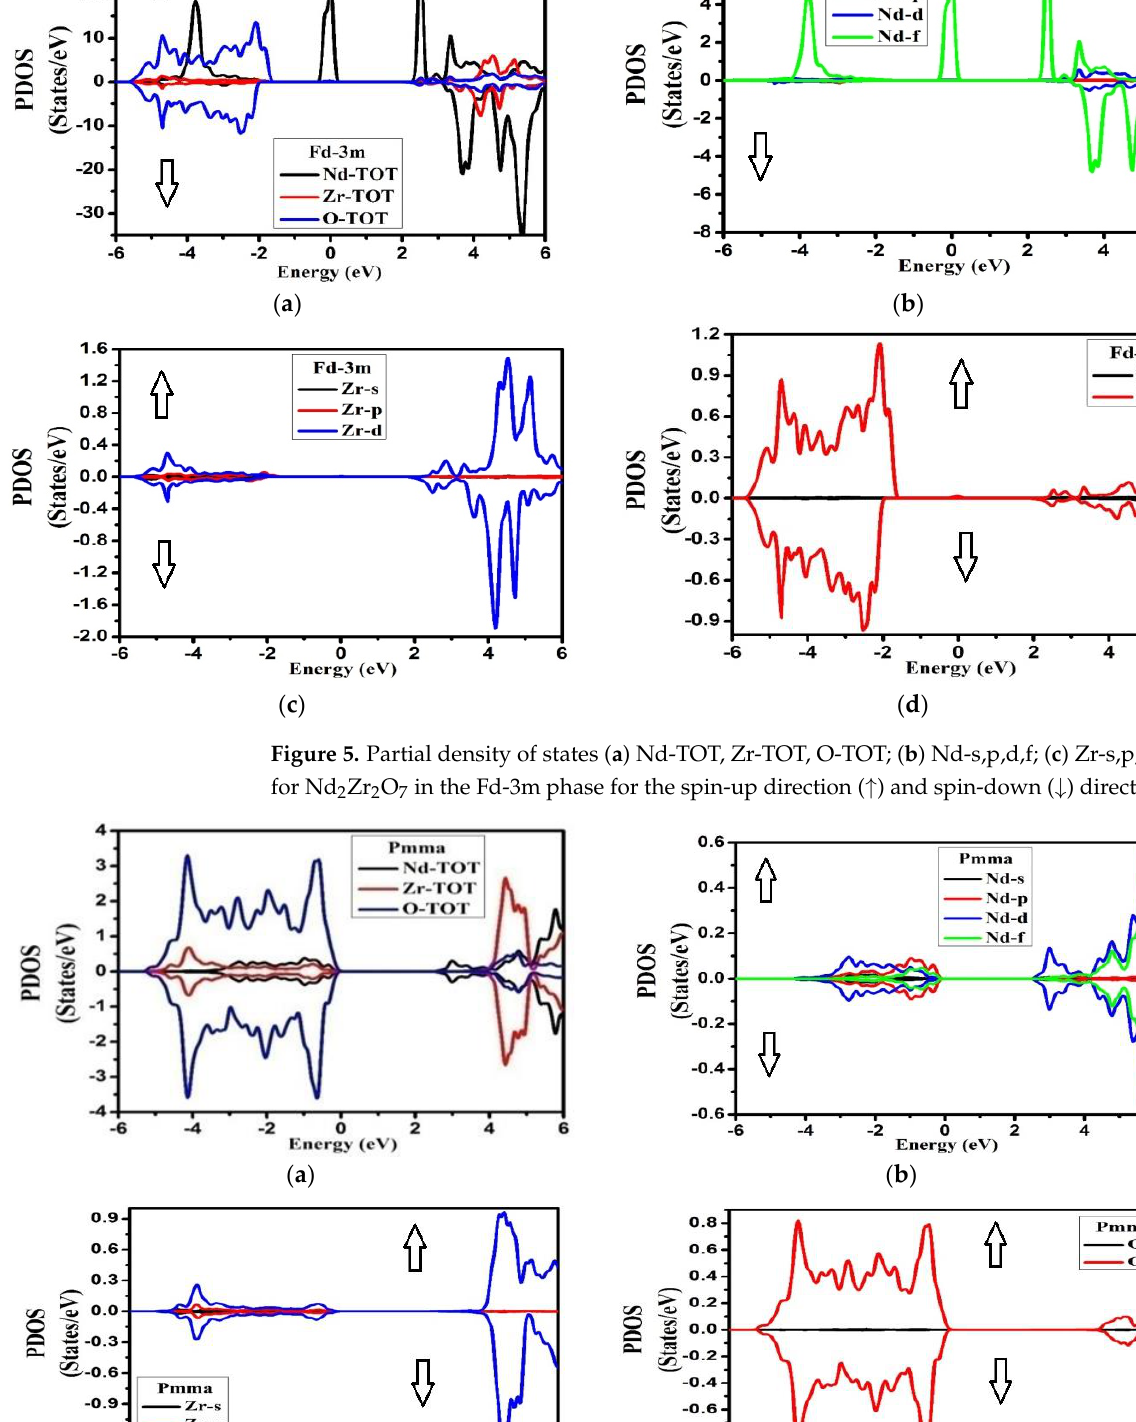
Figure 4. Total density of states for Nd 2 Zr 2 O 7 in Fd-3m and Pmma phases for the spin-up direction ( ↑ ) and spin-down ( ↓ ) direction.